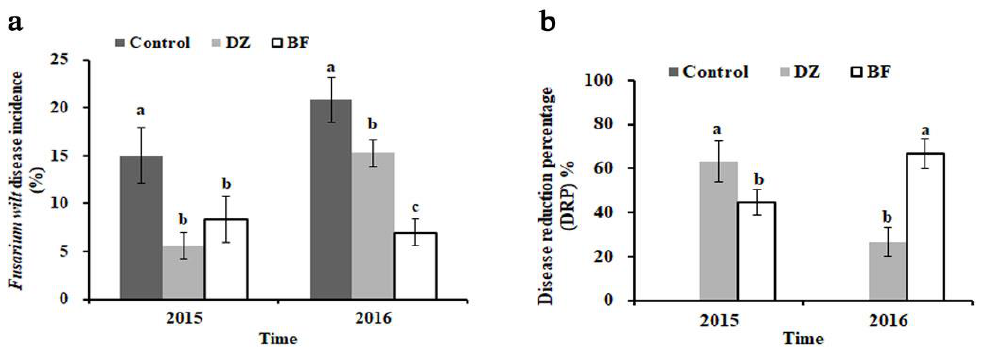
Figure 2. Fusarium wilt ( a ) incidence and ( b ) disease-reduction percentage of chrysanthemum ‘ Jimba ’ treated with DZ and BF. Note: Bars represent the mean, and whiskers represent the standard deviation. Control: no treatment, DZ: 30 g dazomet per m 2 soil, BF: 30 g biofungicide per m 2 soil. Letters above the bars indicate a significant difference according to Duncan’s multiple range test at the p < 0.05 level.